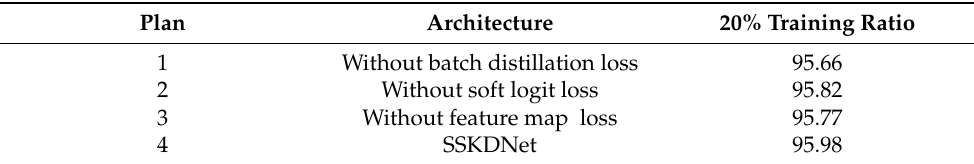
Table 7. Ablation experiments of loss function on the AID